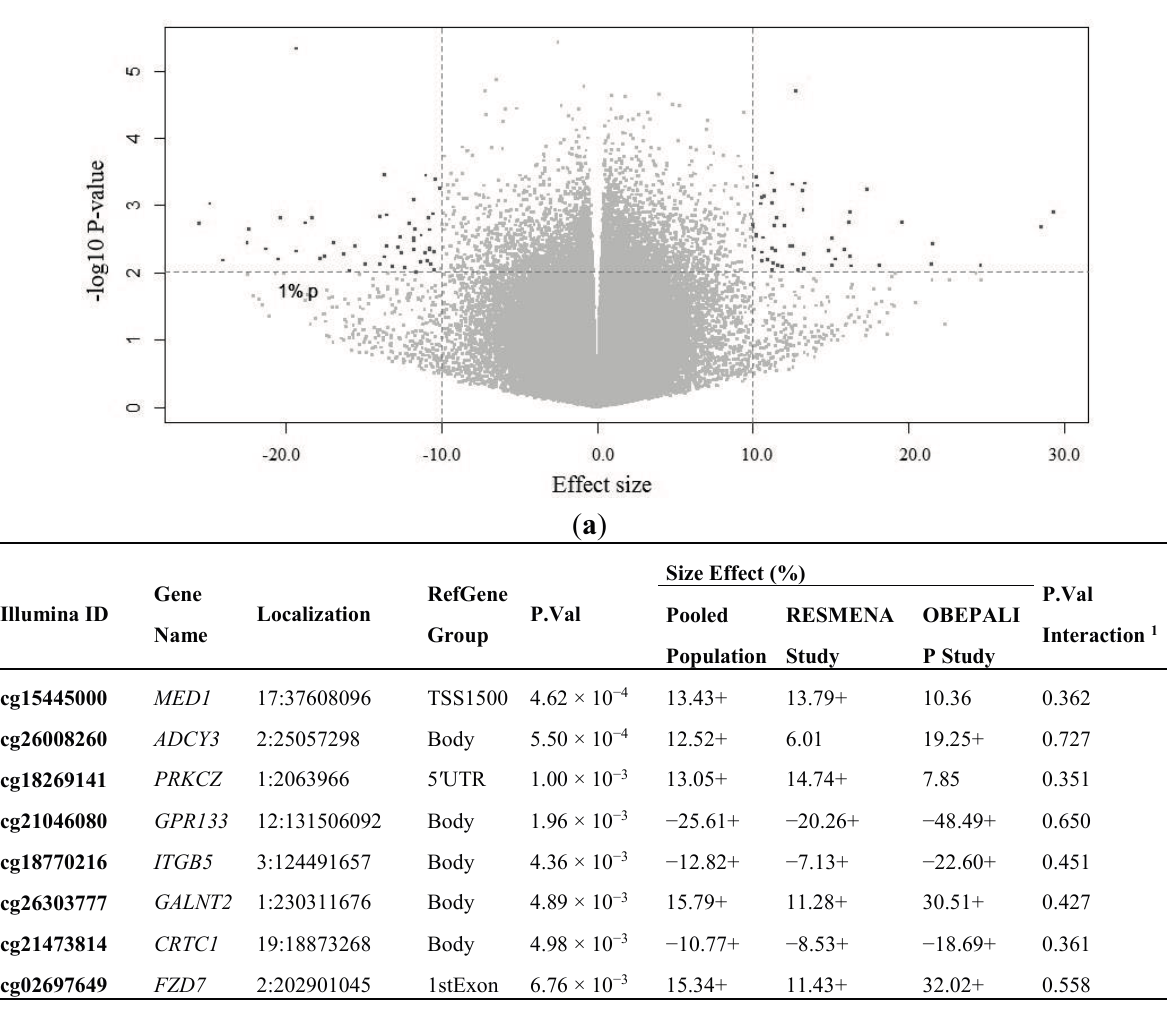
Figure 2. Identification of CpGs and genes differentially methylated between “Low HRO” and “High HRO” subjects. ( a ) Volcano plot of the 358,639 CpG sites of raw p -values log versus mean methylation differences (effect size) comparing Low HRO group to High HRO groups. Hypermethylation means more methylation in the Low HRO group compared to the High HRO group, and hypomethylation refers to less methylation in the Low HRO group than in the High HRO group. CpG sites hypermethylated ( n = 44) and hypomethylated ( n = 41) are shown in black; CpG sites that were not differentially methylated (raw p -value > 0.01) are shown in grey; ( b ) p -values and effect size of the selected CpG sites between groups. CpGs are ranked by p -value, from smallest to